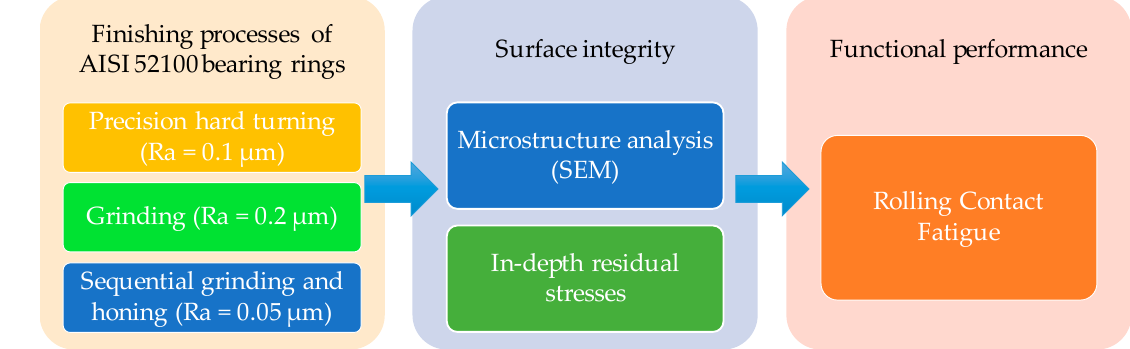
Figure 1. Workflow of the present study.